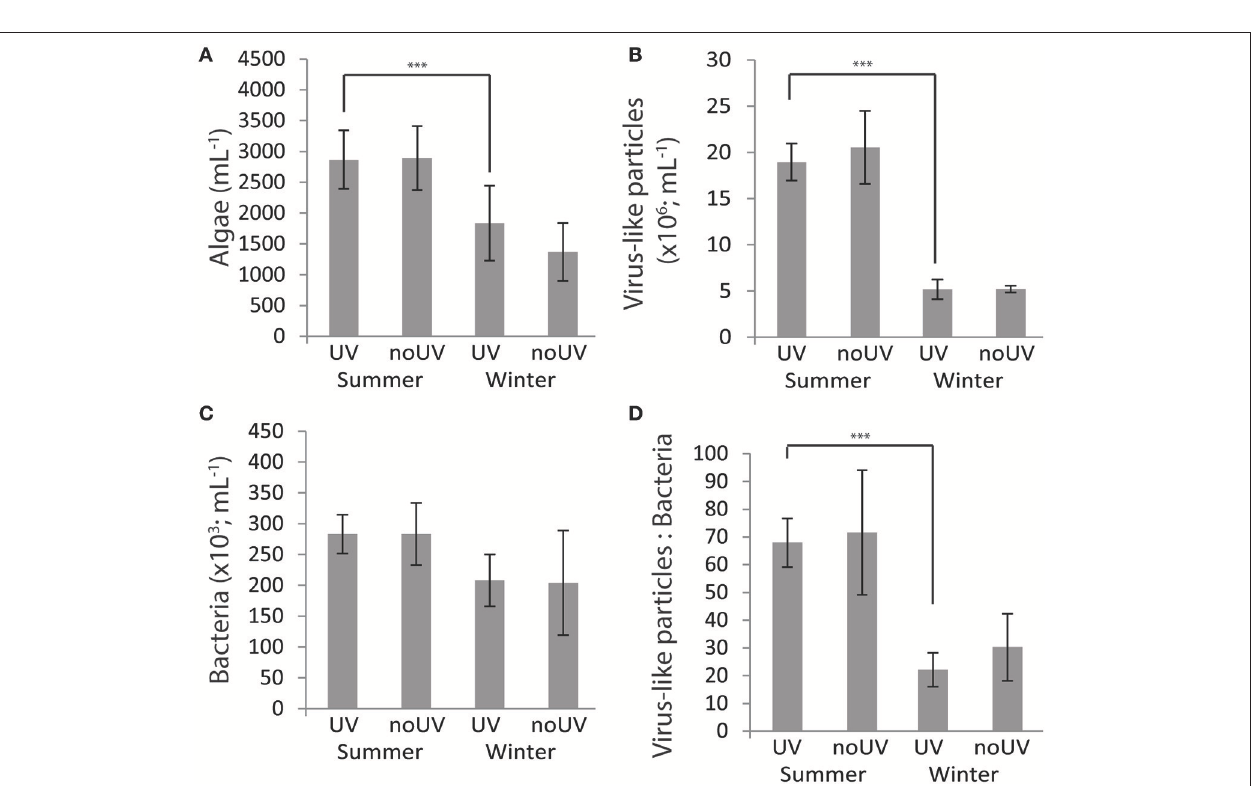
FIGURE 6 | Concentrations of (A) algae, (B) viruse-like particles (VLP) and (C) bacteria and (D) the ratio VLP:bacteria in the seawater under ambient and no UVR conditions at two contrasting seasons (summer and winter). Data are the mean and standard deviations of five biological replicates. Comparisons indicated with ***are significantly different ( p <